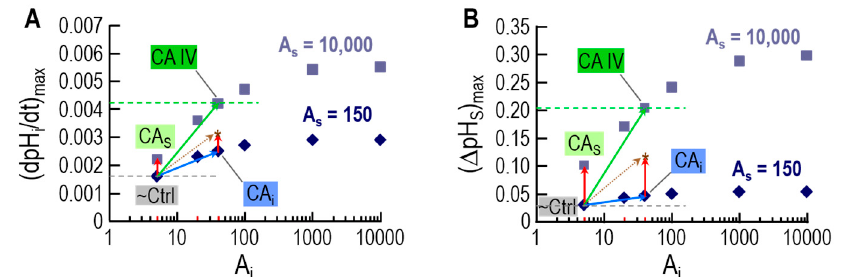
Figure 6. Supra-additive e ff ects of intracellular and extracellular-surface CA activities on kinetics of pH changes, as predicted by mathematical modeling. The insets to Figure 4 show the protocol of the physiological experiment: the addition of CO 2 / HCO 3 − to the extracellular fluid causes: (a) a quasi-exponential decrease of intracellular pH (pH i ); and (b) a rapid increase in the pH at the extracellular surface (pH S ), followed by a quasi-exponential decay. ( A ) The maximal rate of the pH i decrease—(dpH i / dt) max —for 12 simulations, 6 varying the intracellular CA acceleration factor (A i ) at a fixed extracellular-surface CA acceleration factor (A S ) of 150 (diamonds), and 6 varying A i at a fixed A S of 10,000 (squares). ( B ) The maximal shift in pH S —( ∆ pH S ) max —for the same 12 simulations in ( A ). Each of the 12 simulations models a hypothetical oocyte exposed to a bulk solution containing 1.5% CO 2 / 10 mM HCO 3 − at pH 7.50. ( A ) Dependence of (dpH i / dt) max on A i , for each of the two di ff erent values of A S . ( B ) Dependence of ( ∆ pH S ) max on A i , for each of the two di ff erent values of A S . In each panel, the six diamonds represent an isopleth for A S = 150, whereas the six squares represent an isopleth for A S = 10,000. In each panel, the diamond labeled “~Ctrl” (i.e., A i = 5, A S = 150) represents a “control” oocyte that is, an oocyte not expressing or injected with any heterologous protein. For “~Ctrl”, the (dpH i / dt) max value in ( A ) and the ( ∆ pH S ) max value in ( B ) approximately match the mean data for physiological experiments, indicated by the horizontal dashed gray lines. In each panel, the square labeled “CA IV” (i.e., A i = 40, A S = 10,000) represents an oocyte expressing CA IV, with (dpH i / dt) max and ( ∆ pH S ) max values approximately matching the mean data for physiological experiments, indicated by the horizontal dashed green lines. In each panel, the square labeled “CA S ” (i.e., A i = 5, A S = 10,000) represents a hypothetical oocyte that—compared to “~Ctrl”—has an isolated increase in A S . Note that the (dpH i / dt) max and ( ∆ pH S ) max values for this hypothetical “CA S ” increase by amounts (red vector) that are far smaller than those actually observed for real oocytes expressing CA IV (i.e., vertical distances between horizontal dashed green and grey lines). The only way for the simulations to explain the physiological data is if CA IV expression not only raises A S from 150 to 10,000 but also raises A i from 5 to 40 (green vector). Indeed, physiological evidence indicates that A i must indeed increase. In each panel, the diamond labeled “CA i ” (i.e., A i = 40, A S = 150) represents a hypothetical oocyte with a cytosolic CA activity that is the same as that postulated for an oocyte actually expressing CA IV (blue vector). The sum of the red vector (increase A S only) and the blue vector (increase A i only) is the point labeled “*” (dashed golden vector). Notice that the green vector predicts that CA IV expression (combined increases in A S and A i ) produces much larger increases in (dpH i / dt) max and ( ∆ pH S ) max than the dashed golden vector (the sum of isolated increases in A S and A i ). In other words, the e ff ects of simultaneously increasing A S and A i are supra-additive. Modified from Figure 13 in